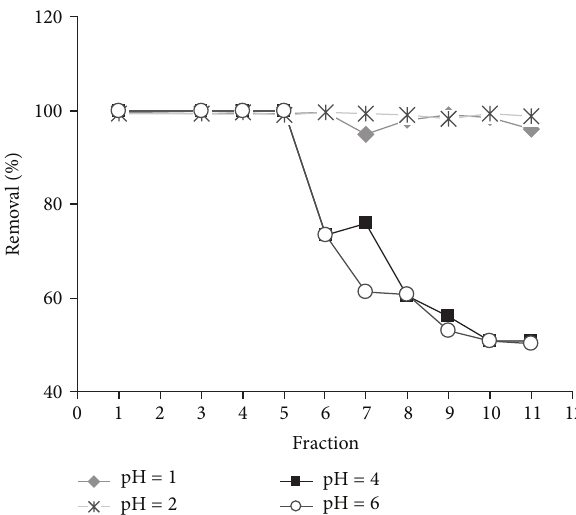
Figure 7: Removal percentage of chromium at pH = 1, 2, 4, and 6 using column filtration. Flow rate = 2 mLmin −1 , eluted Cr(VI) concentration = 50mg L −1 , and temperature = 25.0±0.2 ∘ C. Volume of each collected fraction = 100mL. Data represent averages of triplicates (standard errors have been omitted to avoid crowding of symbols).